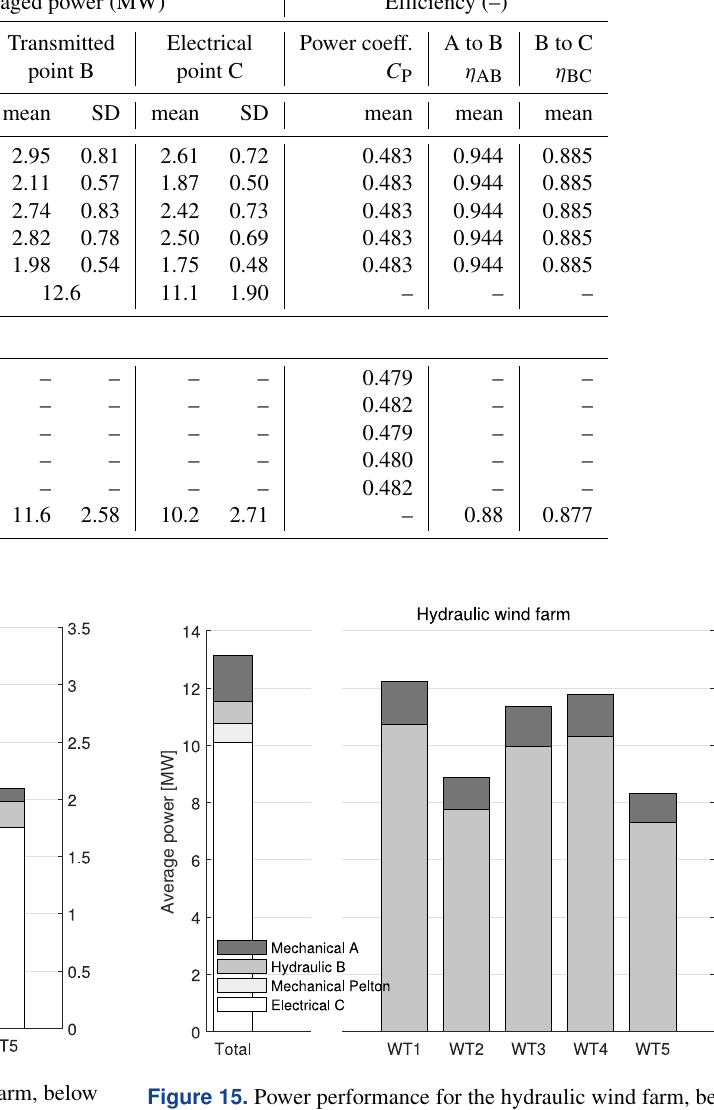
Figure 15. Power performance for the hydraulic wind farm, below rated